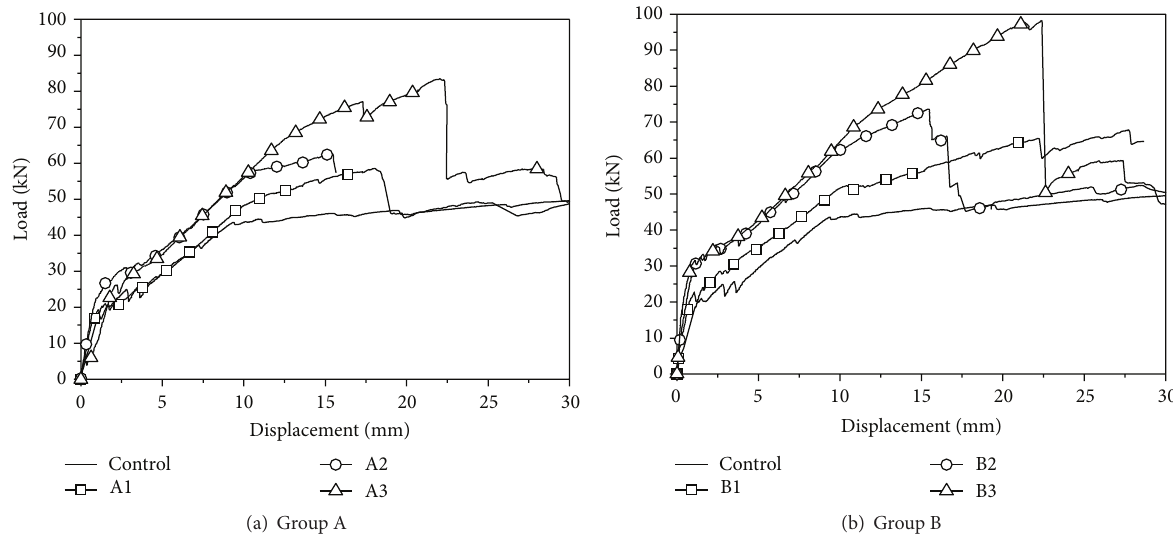
Figure 5: Load-displacement curves of